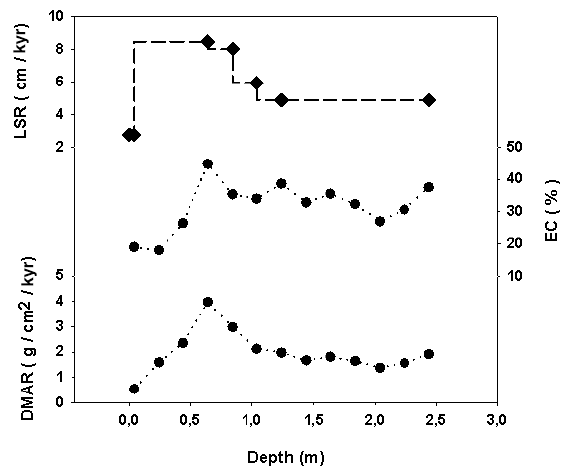
Figure 2. Example of different resolution of SBMAR and EC (Clemens and Prell,